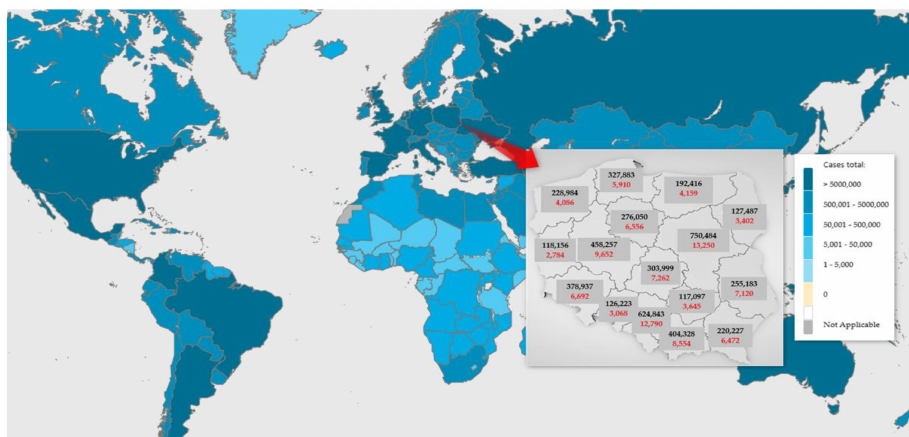
Figure 1. Map indicating the number of COVID-19 infections worldwide and in Poland (by voivode- ships). Source: [1,4].